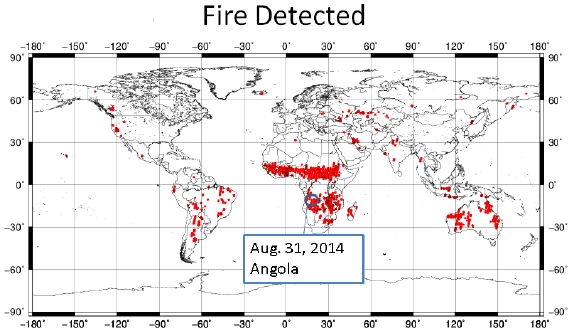
Figure 12. Fire detected (during July 2014 to January 2015).